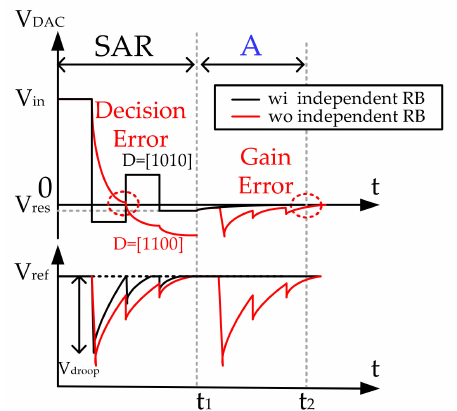
Figure 3. Transient waveforms of the residual voltage and the output of the reference buffer in one stage of a pipelined-SAR ADC. The red line indicates the situation with no independent RB, which has a larger droop in the SAR phase and unwanted function during amplification, causing possible decision error and gain error,